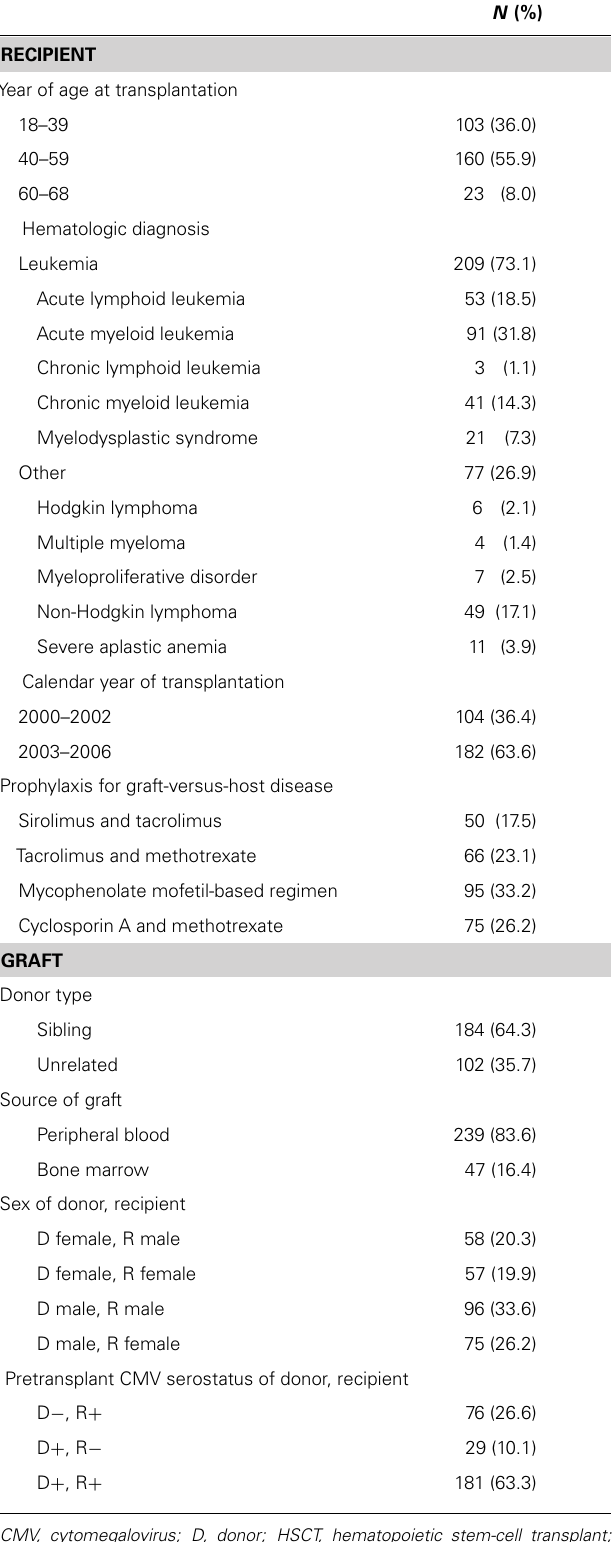
Table 1 | Characteristics of HSCT recipients and grafts ( N =